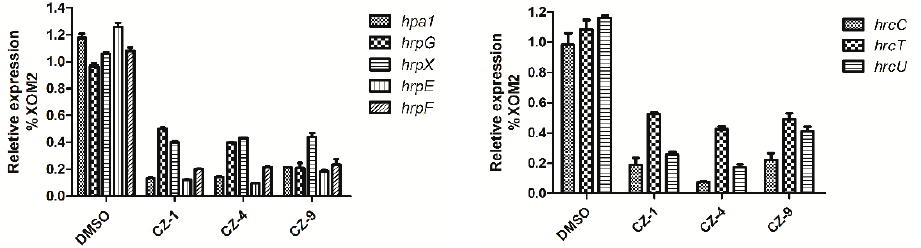
Figure 4. The effect of the three T3SS inhibitors on the expression of representative genes in the hrp cluster.